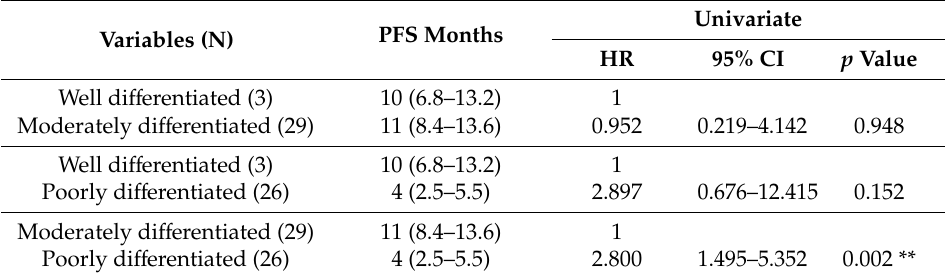
Table 4. Factors associated with progression-free survival (PFS) under chemotherapy.